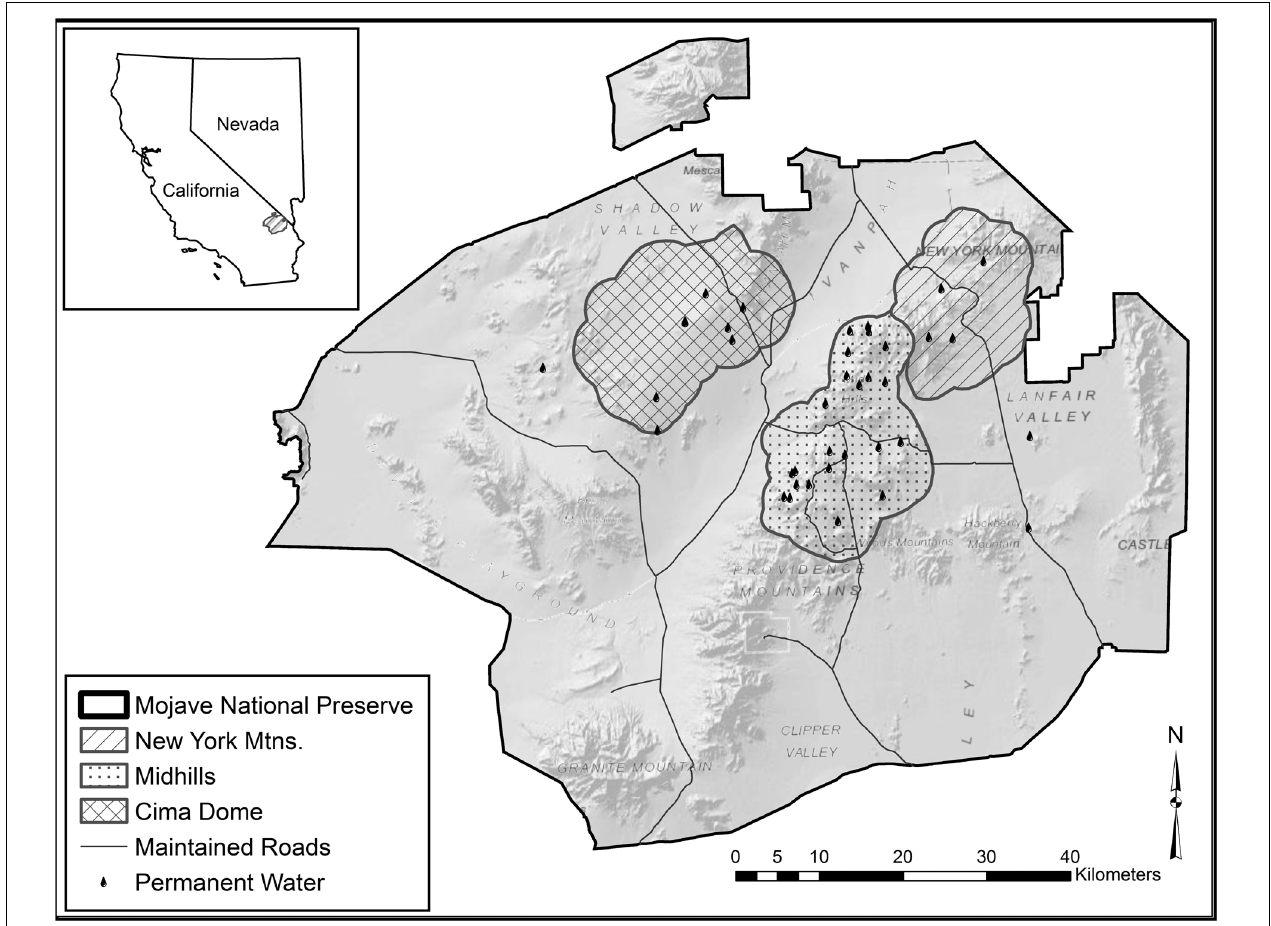
FIGURE 1 | Map of the Mojave National Preserve, CA, United States, with study area delineations and permanent water occurrences exhibited in the Mojave Desert. Inset map shows location relative to Nevada and California, United States (shaded). Figure recreated from McKee et al.